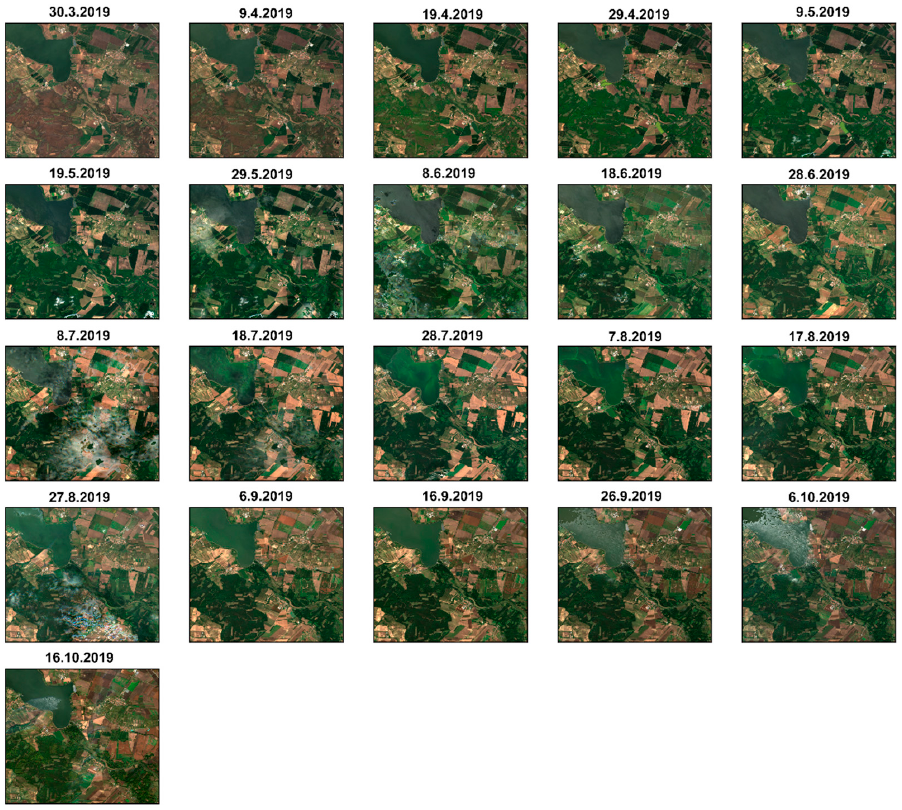
Figure 5. The filtered and interpolated Sentinel-2 time series from 30.3.2019 to 16.10.2019 of feature time frames on the example of EOPatch with ID 7.